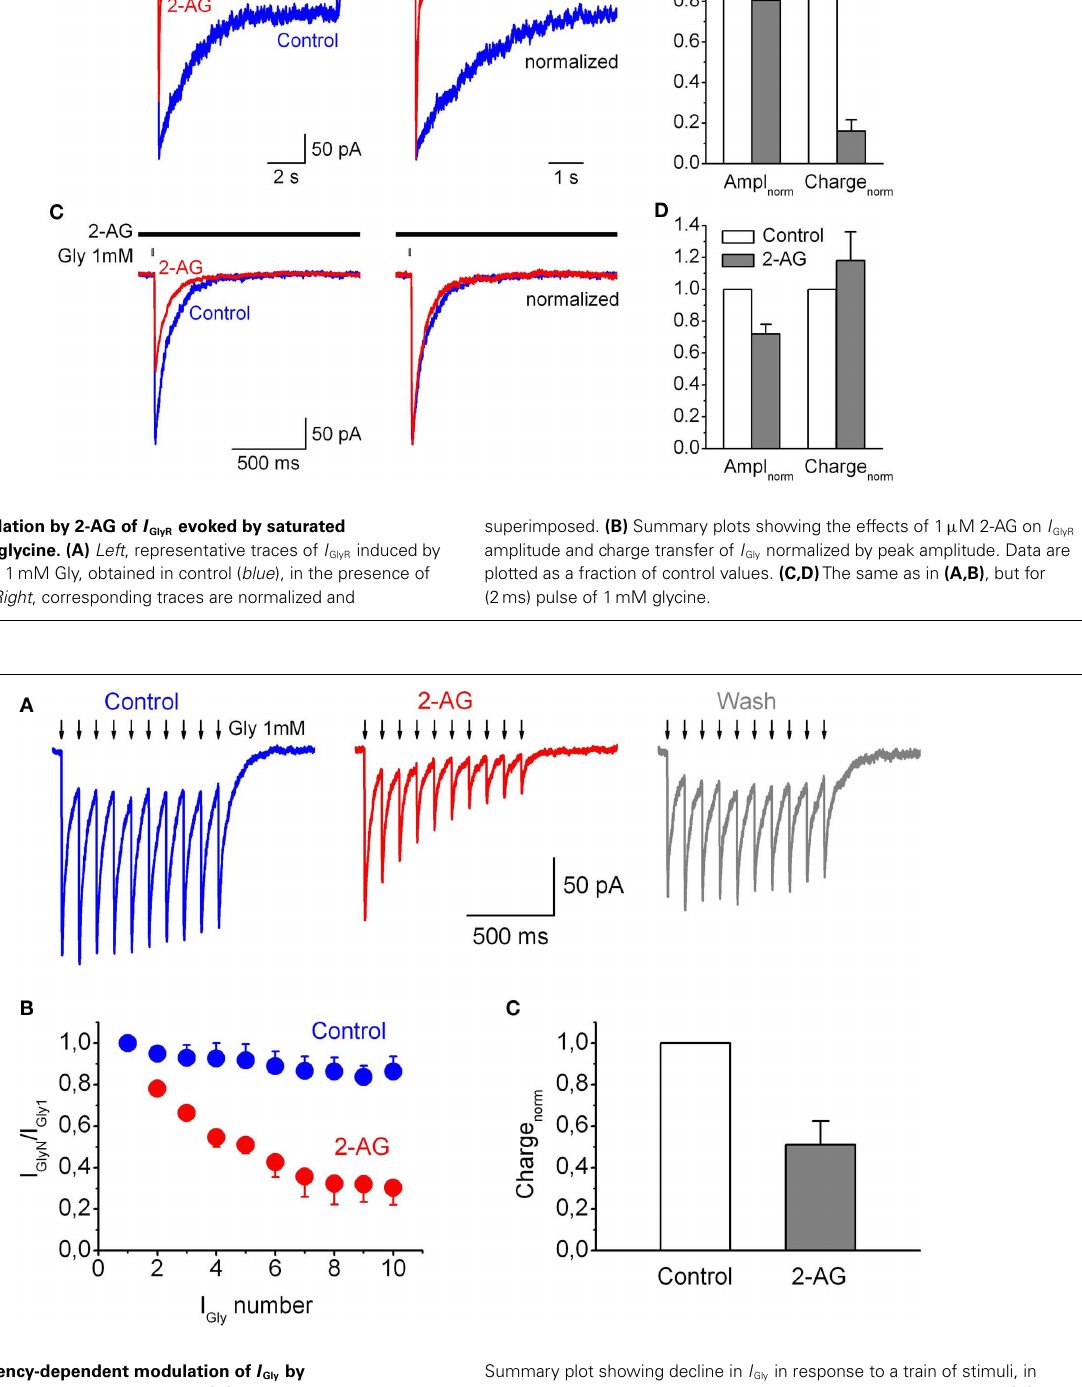
Summary plot showing decline in I Gly in response to a train of stimuli, in control (blue circles) and in the presence of 1 μ M 2-AG (red circles). (C) Averaged total charge of I Gly in response to a train of stimuli normalized by first peak amplitude, in the presence of 2-AG as a fraction of control value. Data from four outside-out